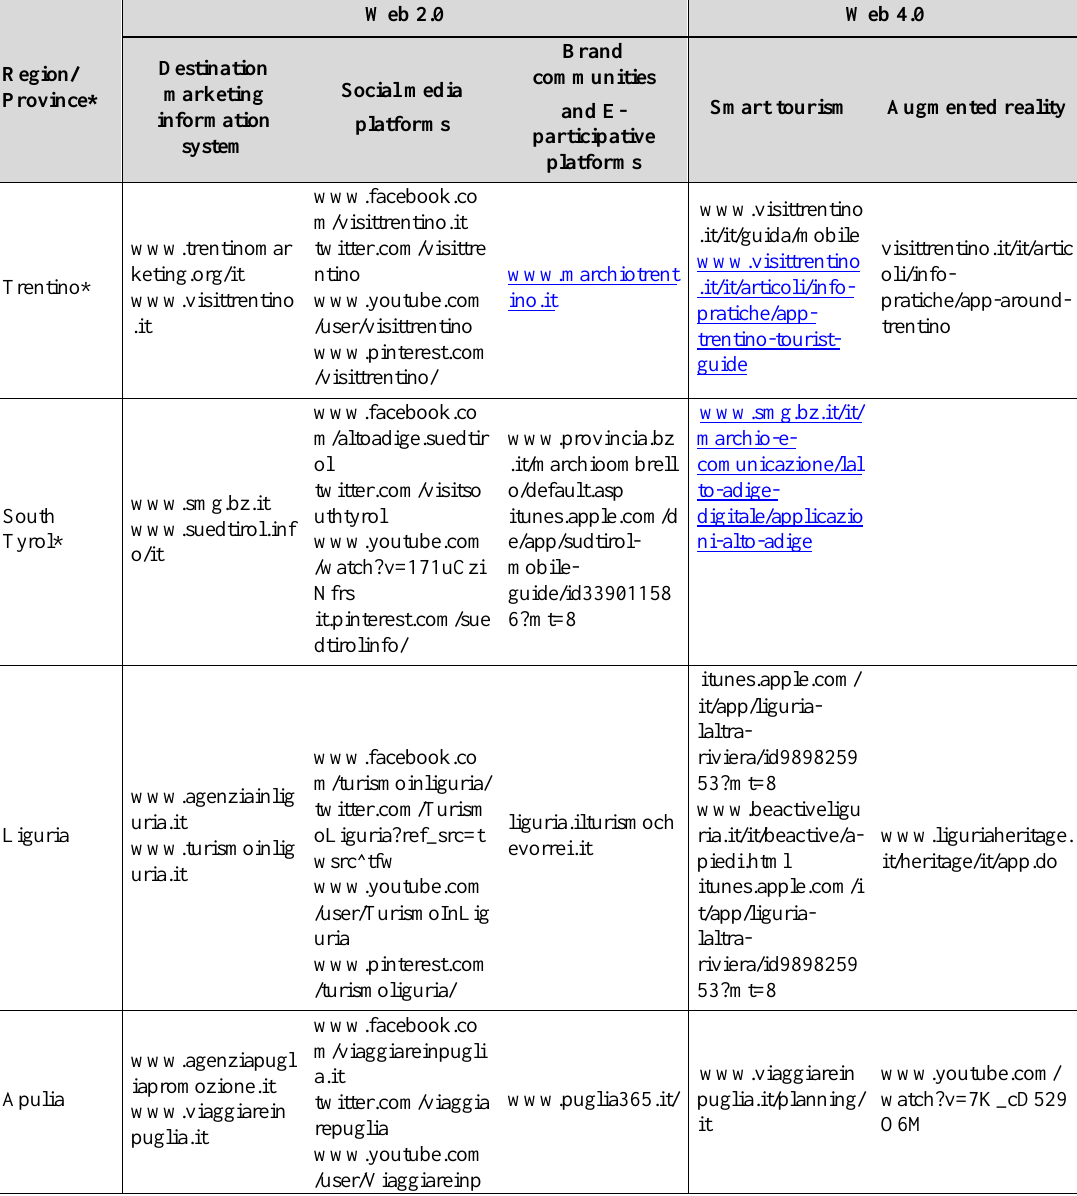
Table 2: From Web 2.0 to Web 4.0 in Italian Regional and Provincial Dmos